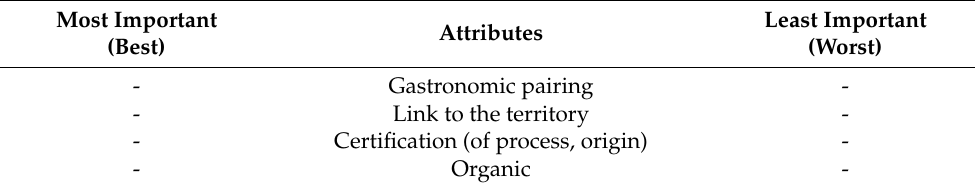
Table 1. Example of best–worst question.